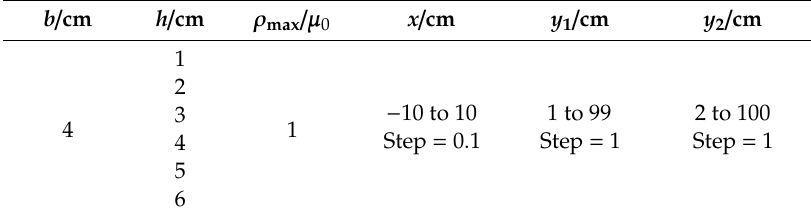
Table A5. The parameter list of MATLAB finite element calculation in Figure